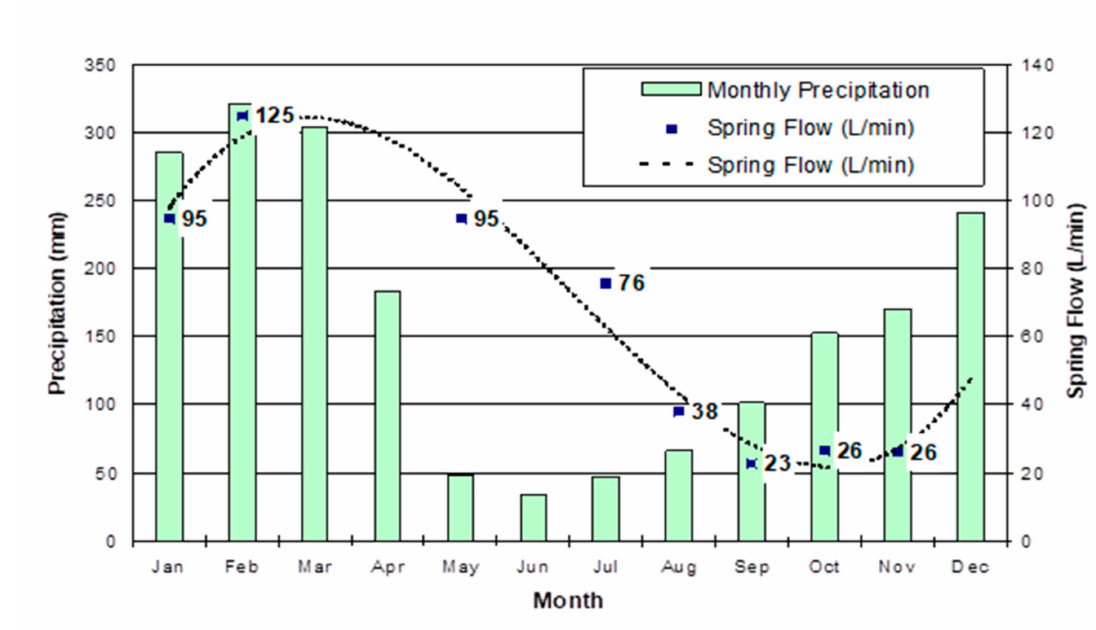
Figure 6. Variations of Inca Spring flow by season. The green bars indicate average precipitation while the squares represent average seasonal measurements of spring flow. The dotted line shows interpolated spring flow, representing a lag time of several months. Based on interpretations of Quelccaya ice cap data [6], modern precipitation data correspond closely with estimated precipitation during the period of Machu Picchu occupation. (Reproduced from Machu Picchu: A Civil Engineering Marvel [5], with permission from ASCE, the